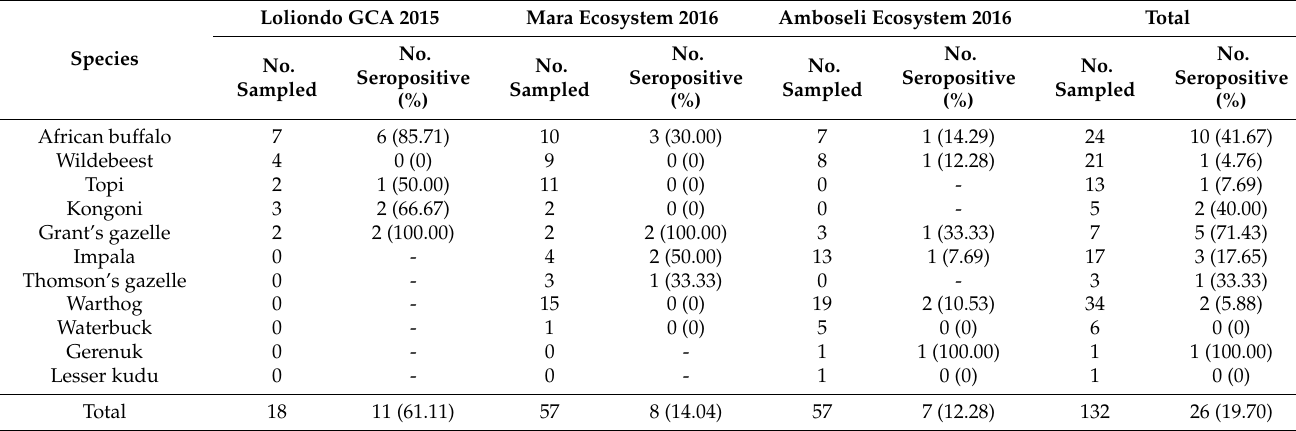
Table 2. Serology results of purposive wild animal sampling, Tanzania and Kenya, 2015–2016. Loliondo GCA 2015 Mara Ecosystem 2016 Amboseli Ecosystem 2016 Species